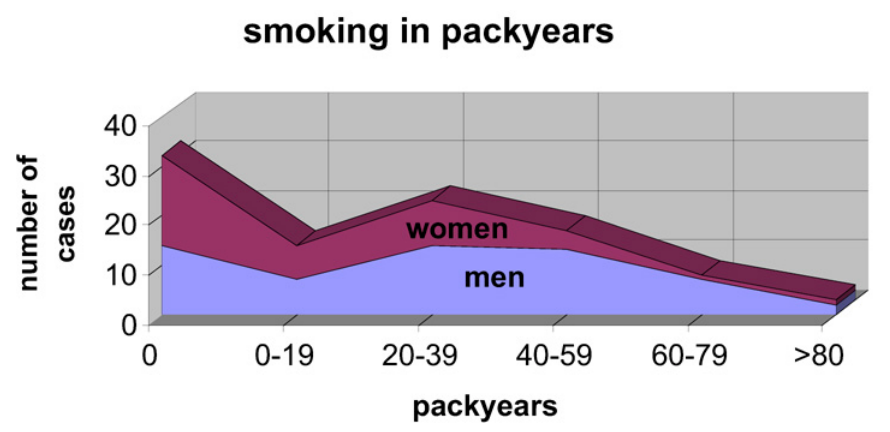
FIGURE 2. Amount of cigarette smoking of patients with pulmonary hamartomas (in pack years).